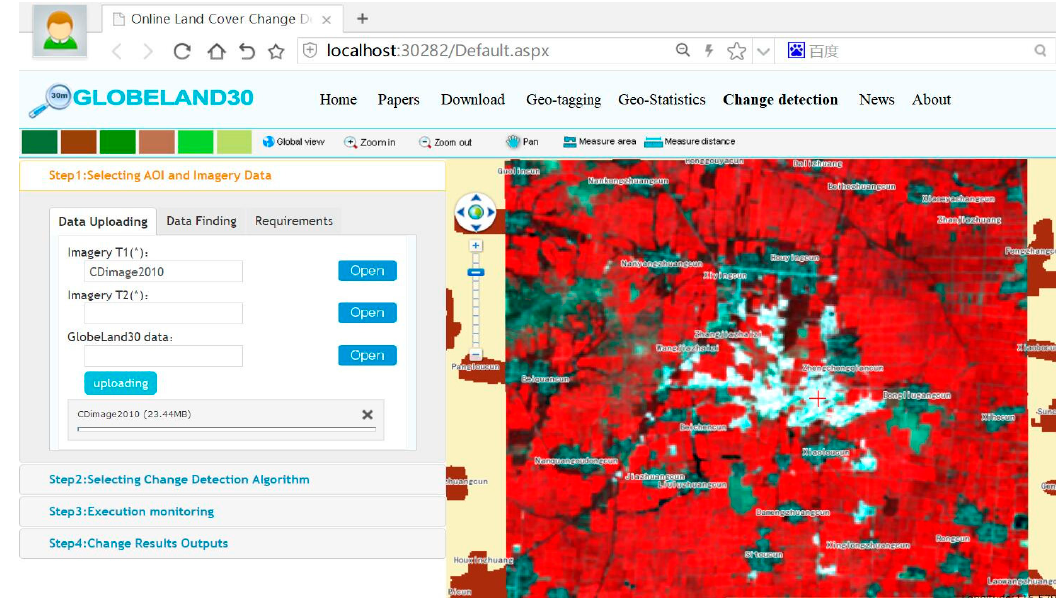
Figure 6. Uploading Landsat 5 data (for year 2010) using OGS-LCCD.